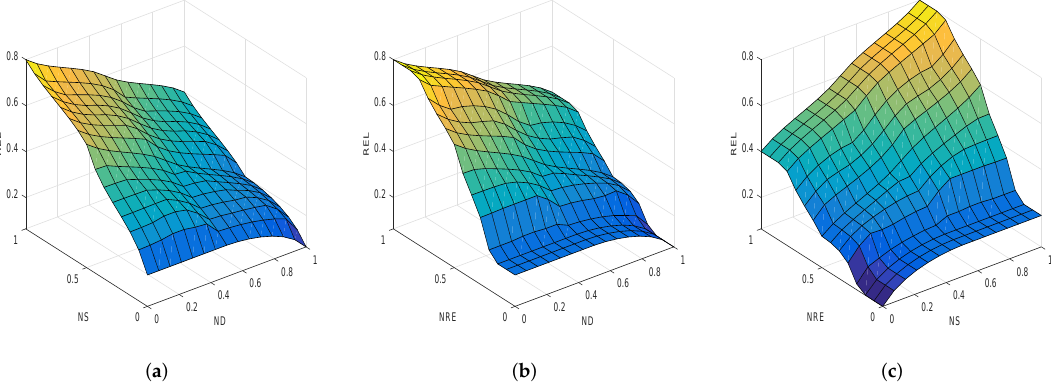
Figure 5. Input and output surface graph of fuzzy inference. ( a ) Inference surface between ND and NS and REL; ( b ) inference surface between ND and NRE and REL; ( c ) inference surface between NS and NRE and